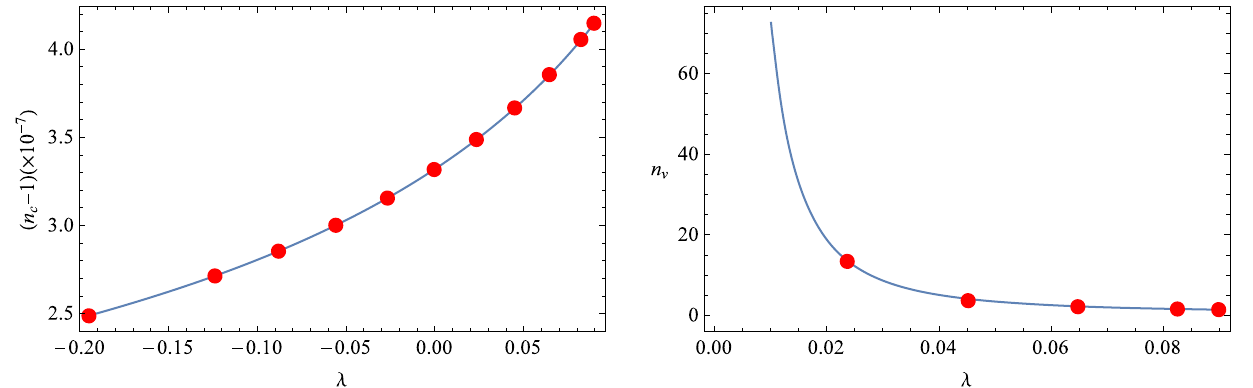
Fig. 10 Left: When the scalar mass is (cid:16) + = 2, the critical Rényi parameters are extremely close to one. So we have sketched n c − 1 as a function of λ . Right: The n v shows the value of n , where the sec-